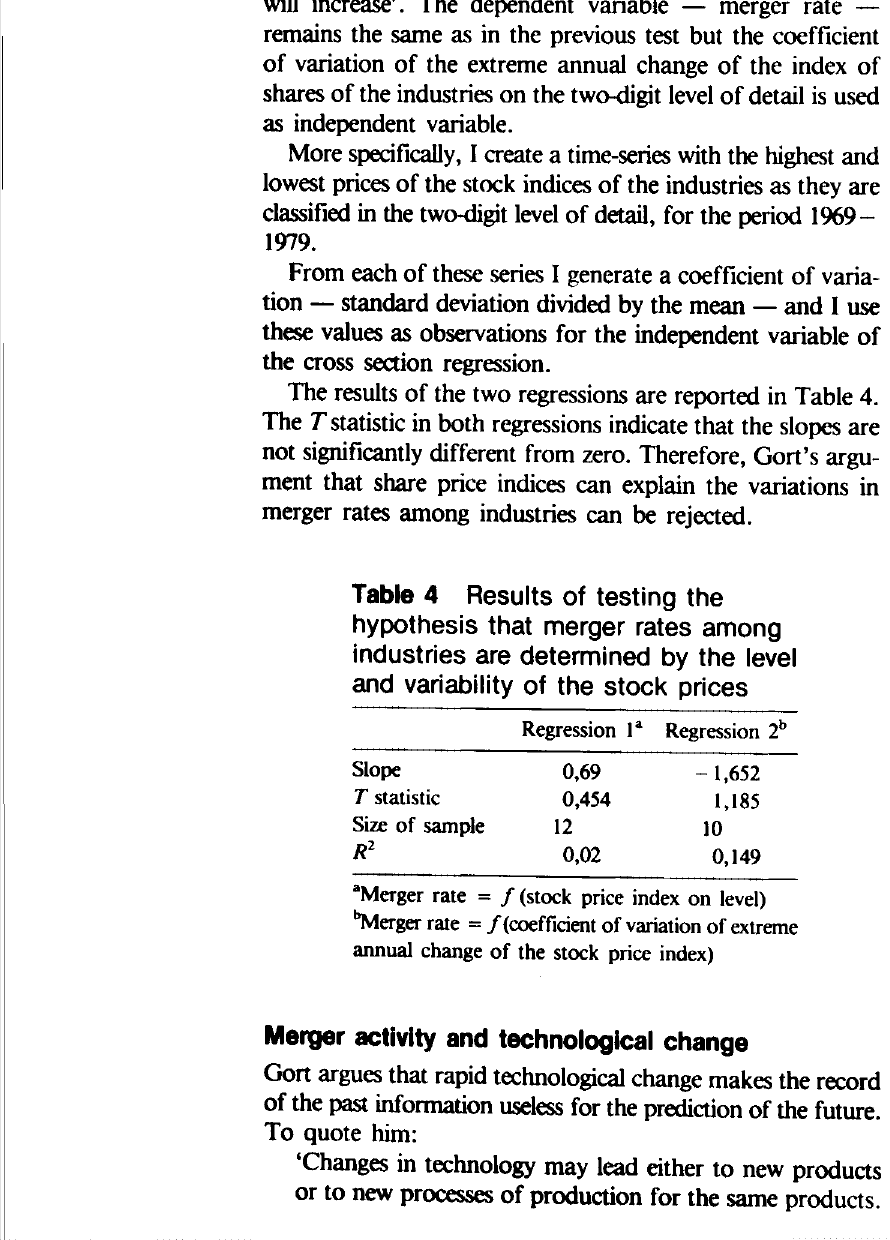
Results of testing the hypothesis that merger rates